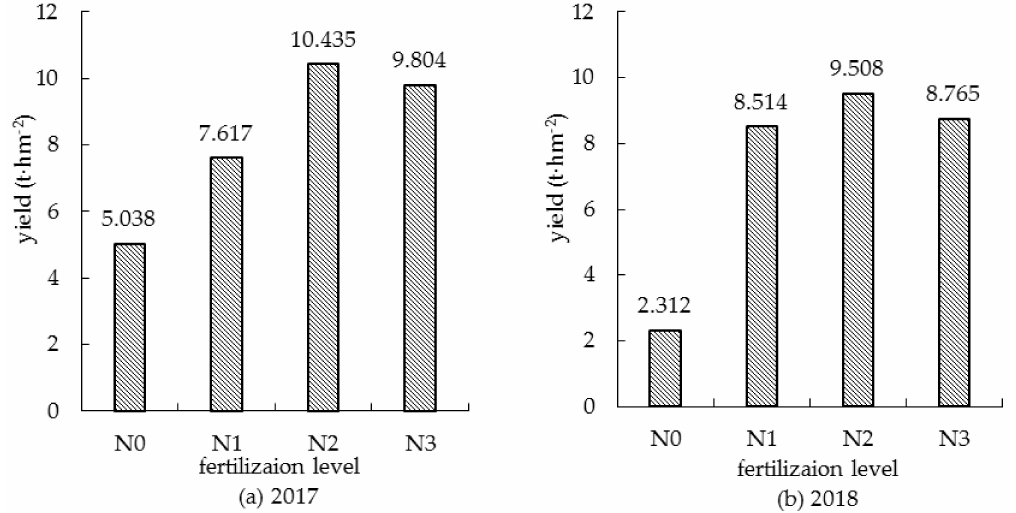
Figure 2. E ff ect of nitrogen application level on yield of summer